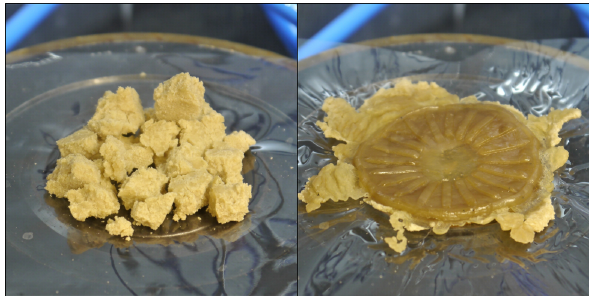
Figure 2: Soy protein matrix with a moisture content of 51.7% before (left) and after (right) measurement in the closed cavity